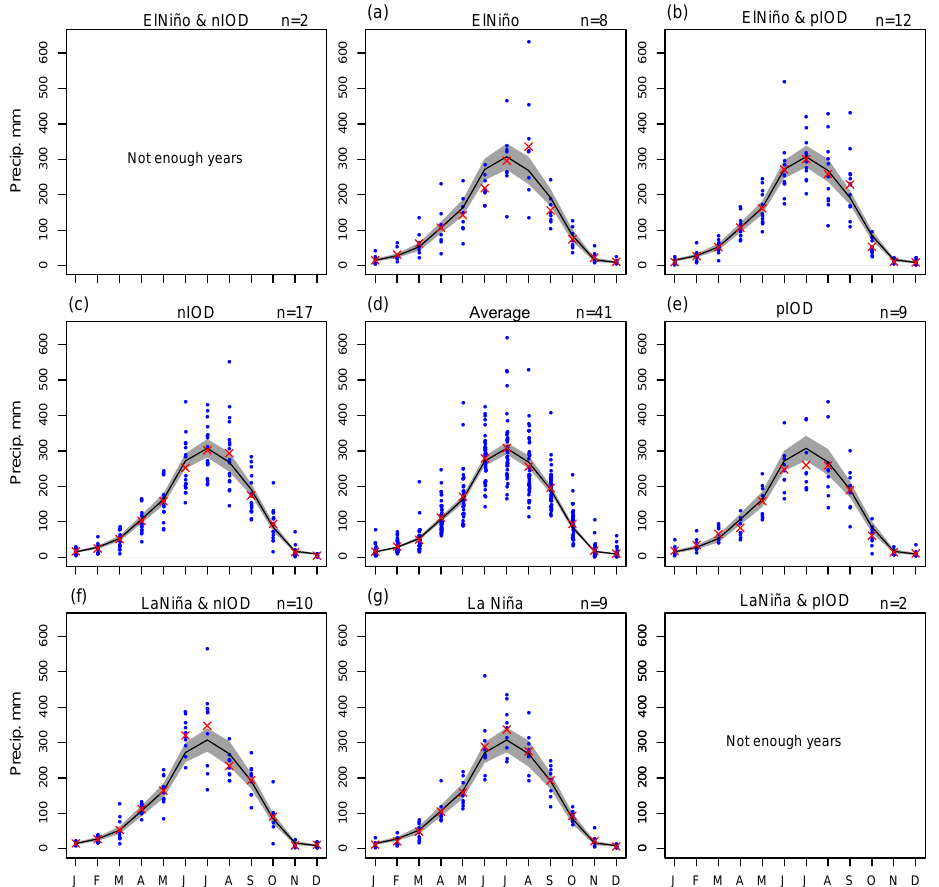
Figure 5. Composite of the Brahmaputra Basin precipitation (mm) by month when El Niño, La Niña, and positive or negative IOD occurred, co-occurred, or did not develop. The number of observed years for each ENSO–IOD combination is indicated with n . The seasonal cycle from January to December is shown for the period 1901–2010. The black line is the mean of all years (1901–2010). Within each combination, observed years ( n) are shown with blue dots, the red X shows the mean of the observed years, and its confidence levels are shown with gray shading as determined by Monte Carlo testing and a two-tailed t test at 80% confidence interval. Where the red X lies outside the gray shaded area, the values are significantly different from the long-term variance of that